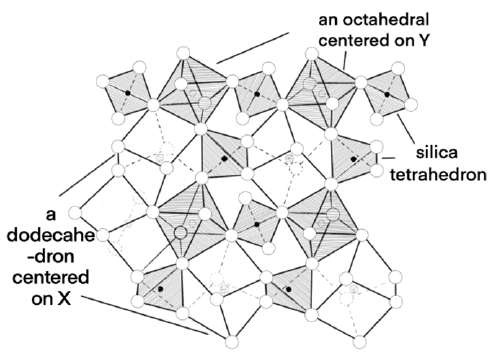
Figure 1. The crystal structure of garnet, modified from Novak et al. [2]. The samples, termed pyrope-almandine, belong to the pyralspite series. In this series, Al 3+ occupies the Y position, and the X position is principally occupied by Fe 2+ and Mg 2+ . However, sometimes a small amount of Mn 2+ can substitute the Fe 2+ and Mg 2+ [9]. The color of minerals depends on the color of the oxide of the elements they have [10]. Mg is insignificant for coloration as a non-transition element, which means the purple-red color is the result of Fe 2+ and Mn 2+ [11,12]. Besides, some trace elements can’t be ignored as they are infrequent in proportion to other elements but have a disproportionately significant influence, such as V 3+ and Cr 3+ . However, this part of the research requires further test [13]. The color, as a comprehensive result of chromophores, makes it difficult to separate the influence of a single element, respectively, during others’ research